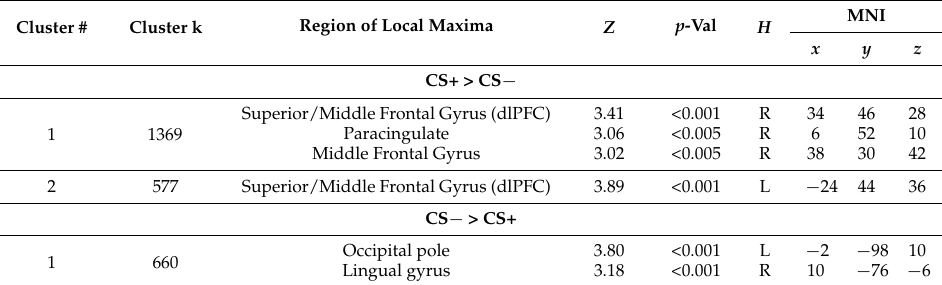
MNI = Montreal Neurological Institute; Cluster # = the nominal cluster number assigned based on cluster size moving from the largest to smallest cluster; Cluster k = number of contiguous voxels; Z = z -score; p -val = p -value derived from z -score; H = hemisphere; L = left; R = right.